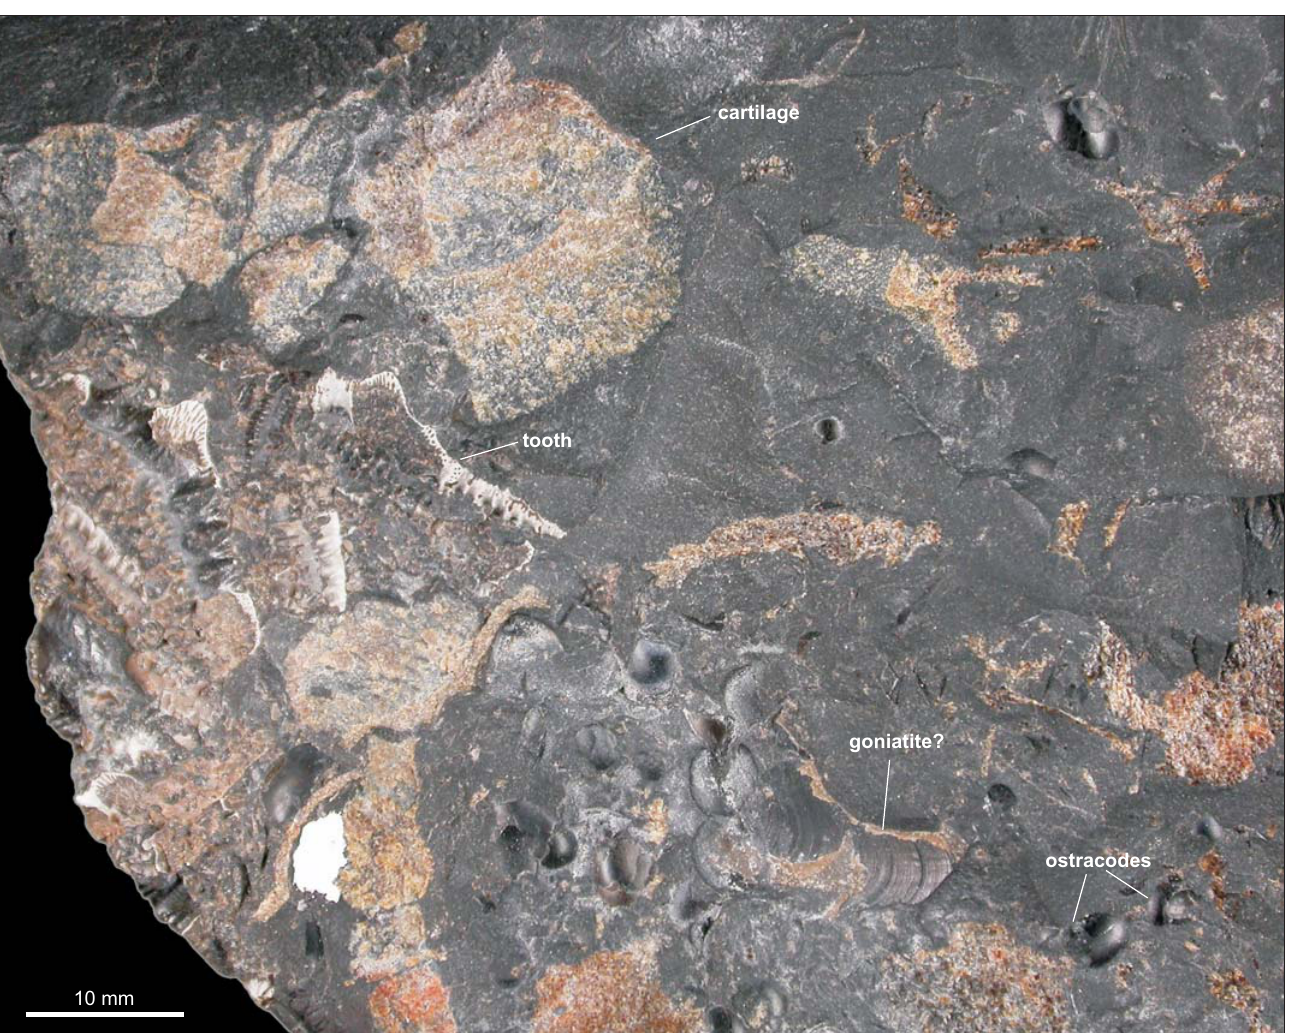
Fig. 3. A part of the dark limestone nodule (GSM 105524) from the Kinderscoutian of Derbyshire, UK, showing the diversity of